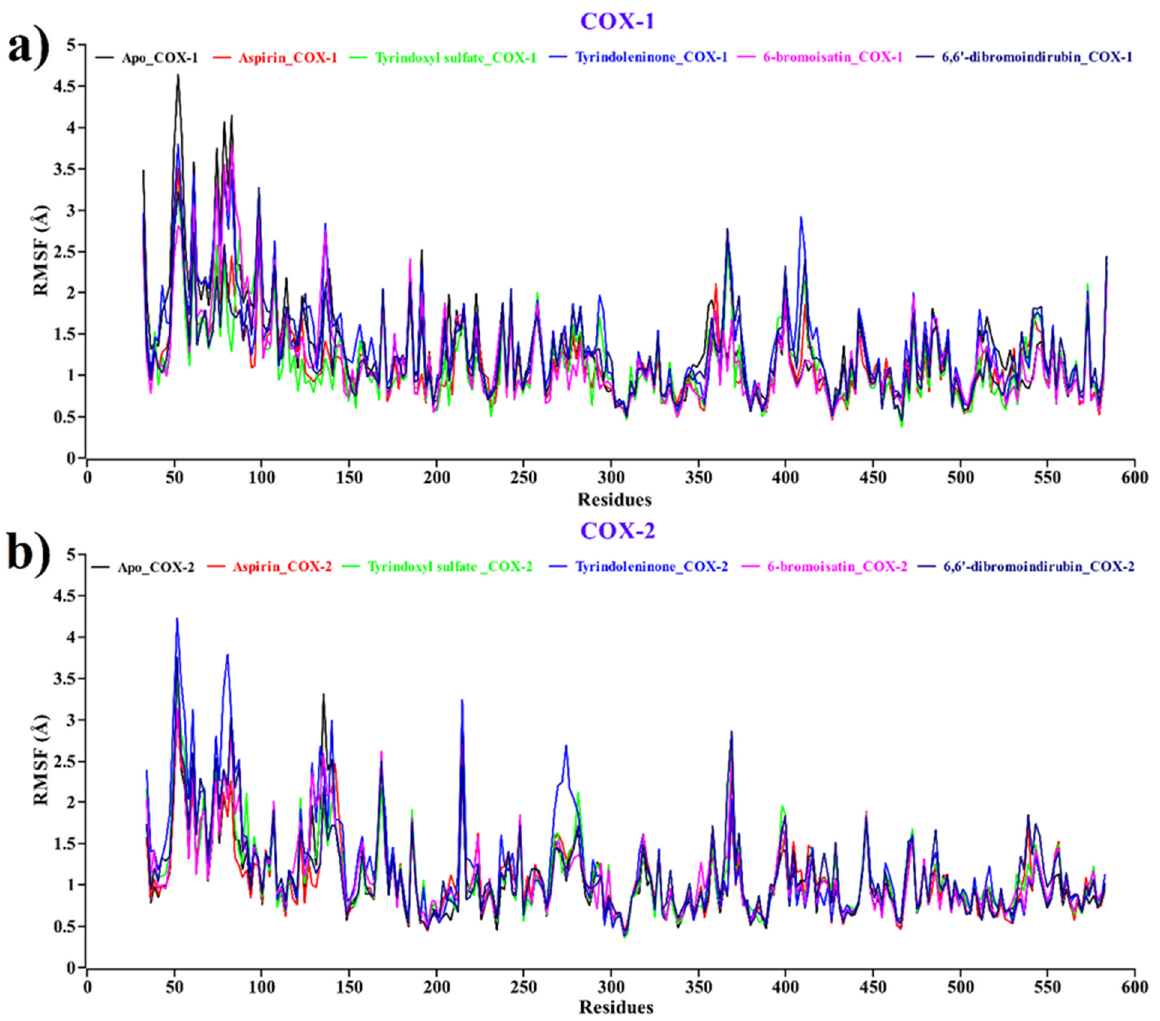
Figure 7. Root mean square fluctuations of protein–ligand of each docked complex for ( a ) COX-1 and ( b ) COX-2. Complexes: Black—apo protein, red—aspirin, green—tyrindoxyl sulfate, blue—tyrindoleninone, magenta—6-bromoisatin, navy blue—6,6’-dibromoindirubin.